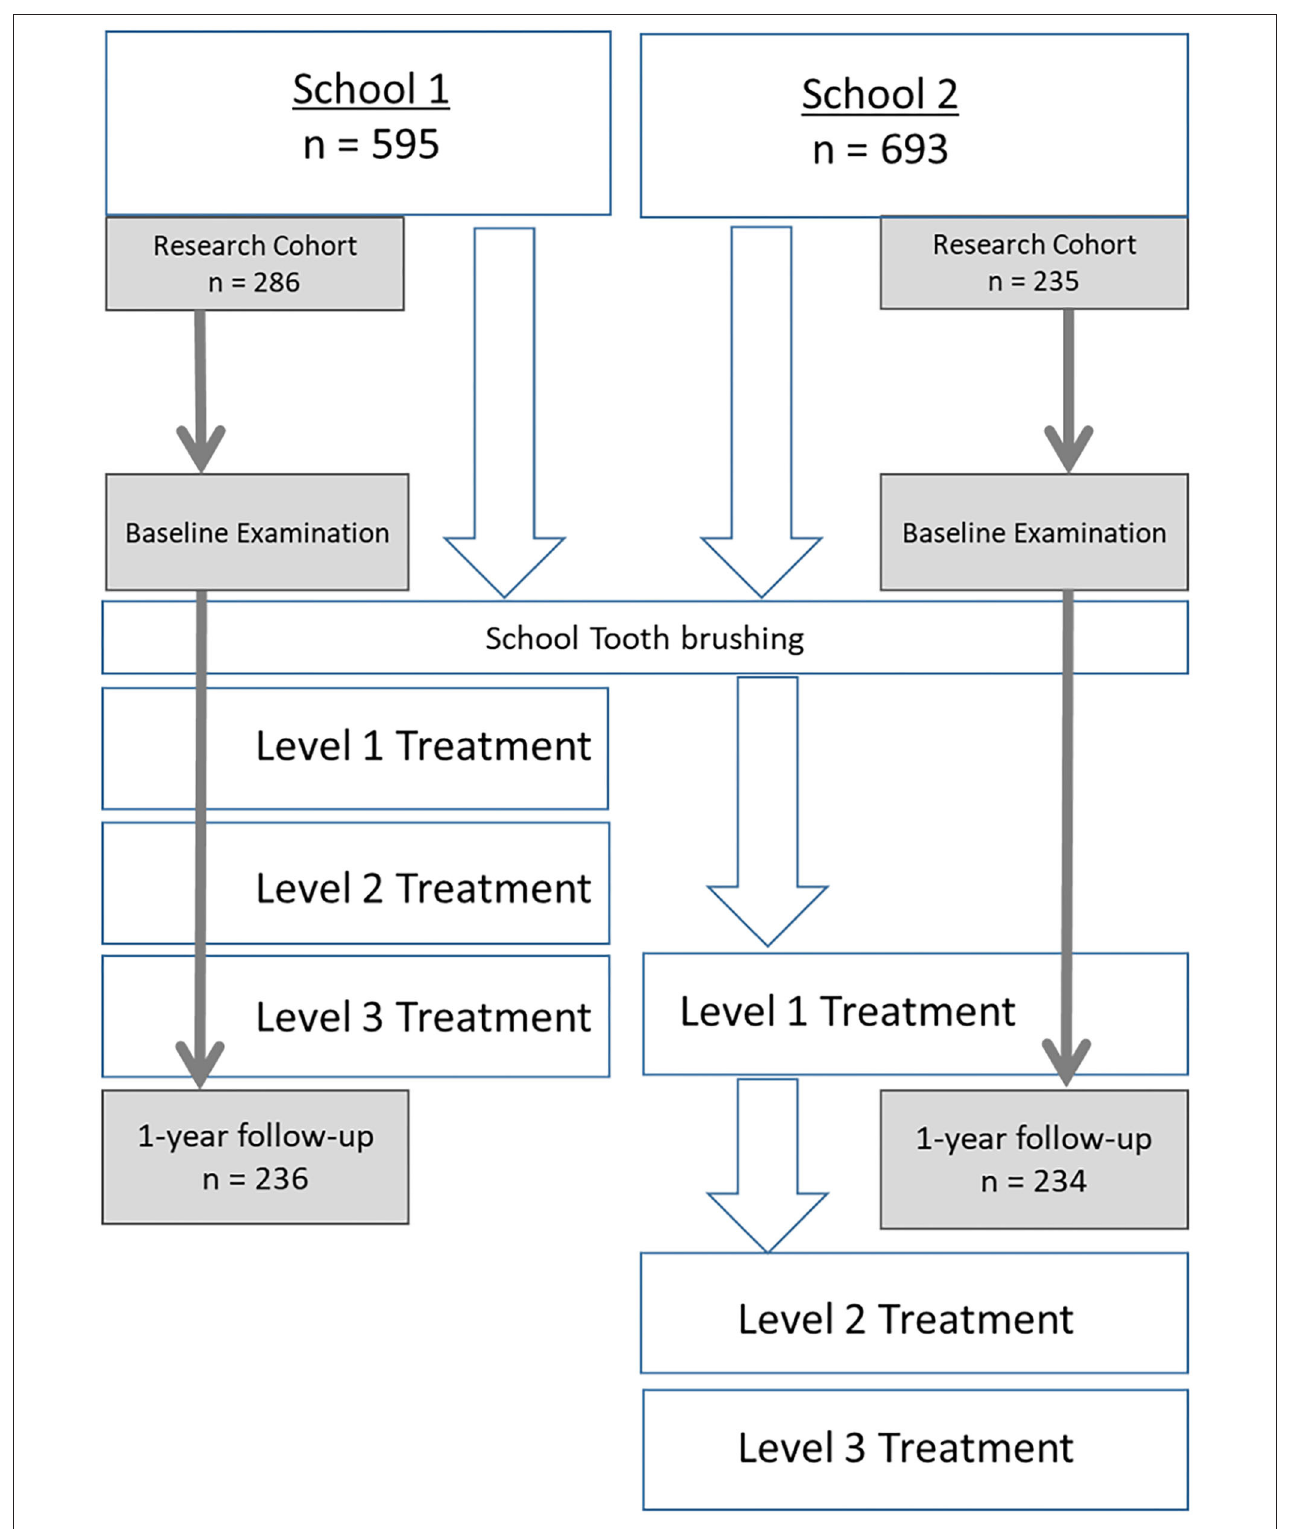
FIGURE 1 | Project flow of